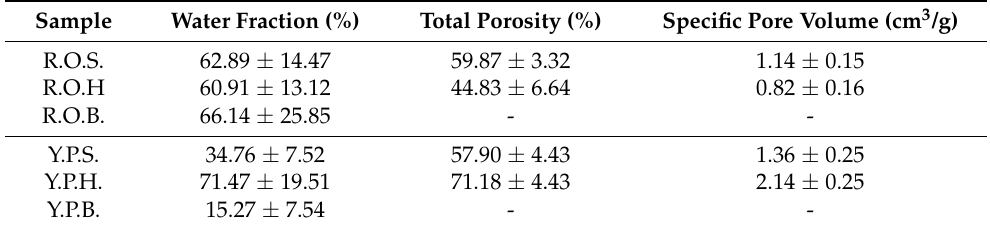
Table 3. Mean and standard deviation for the water fraction, total porosity, and specific pore volume of sapwood, heartwood, and bark components of red oak and yellow poplar.